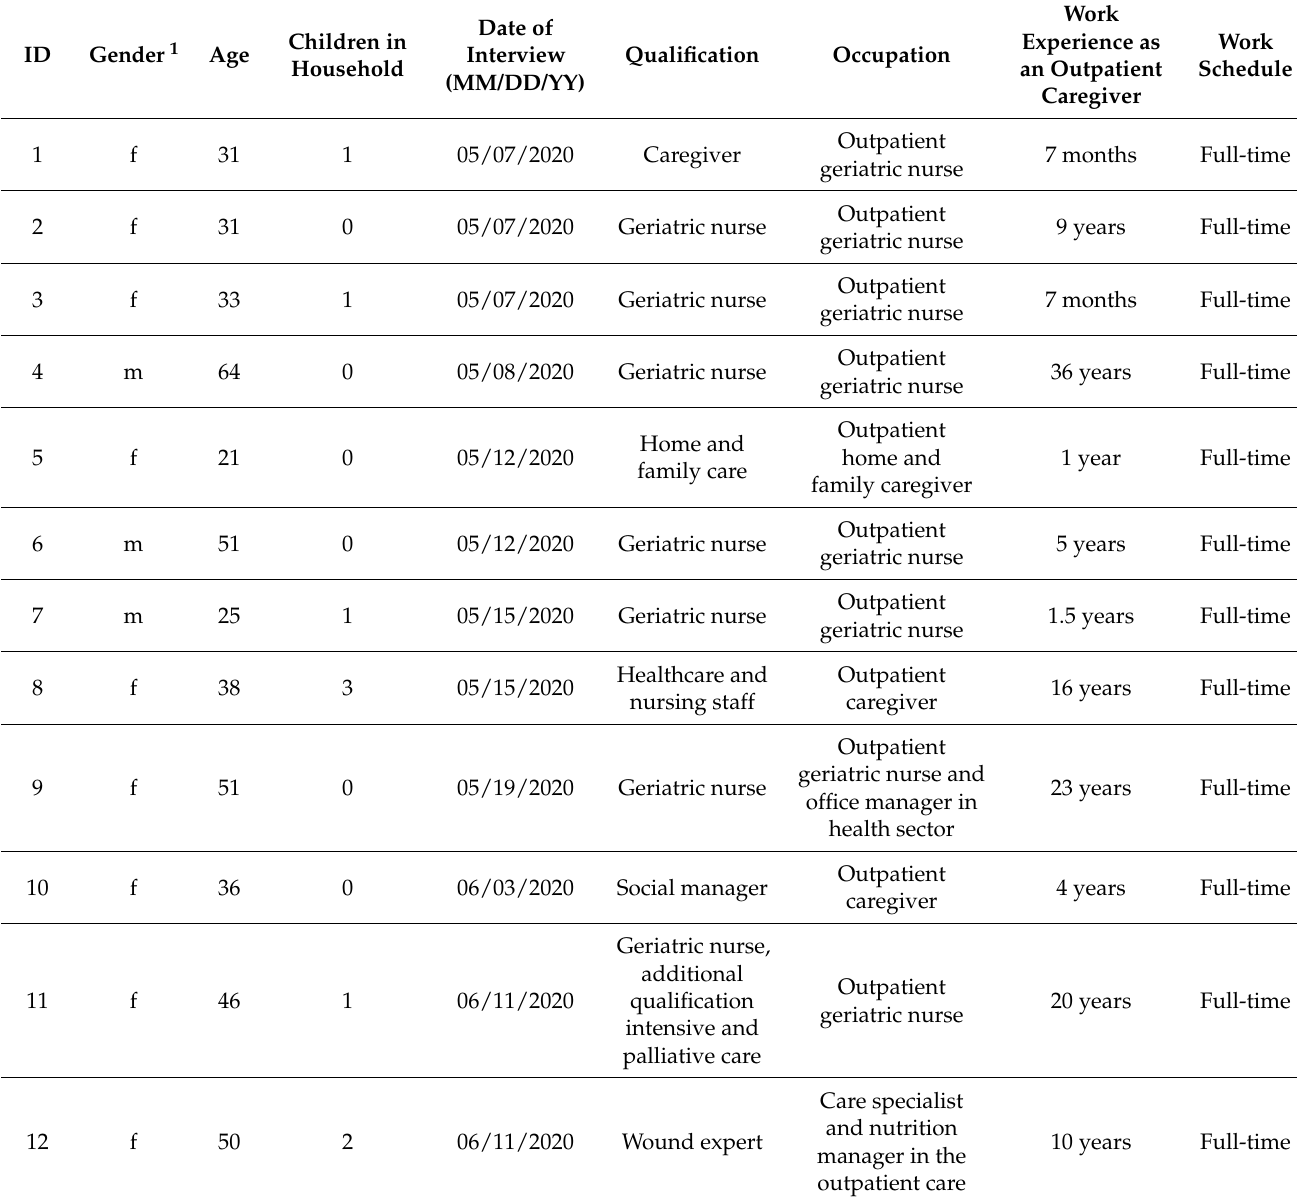
Table 2. Participant